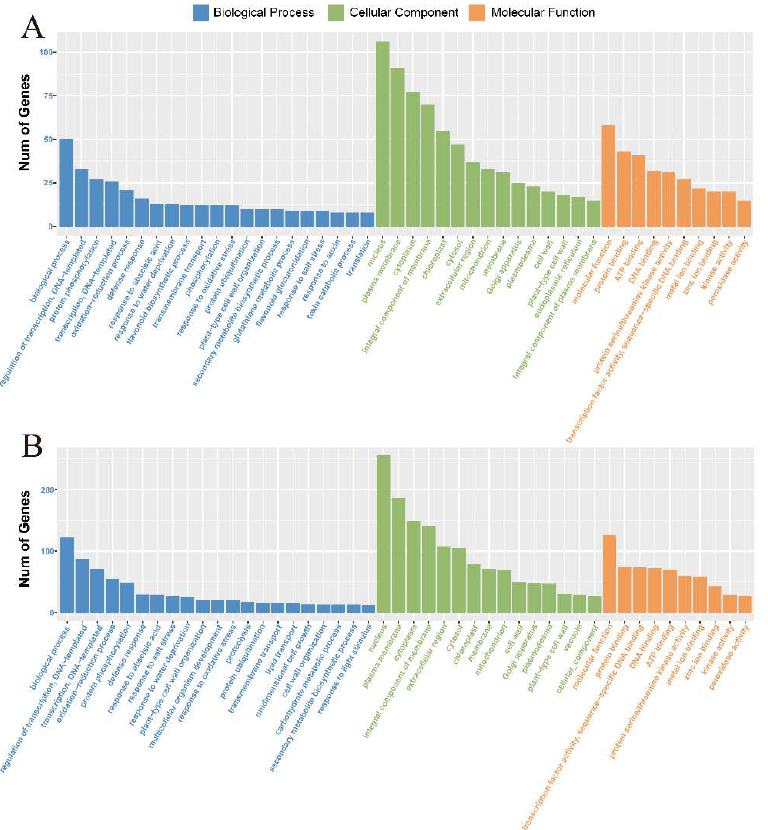
Figure 3 . Functional annotation of assembled sequences based on gene ontology categorization in M-81E ( A ) and Roma ( B ). Results are summarized under three main functional classes: biological processes, molecular functions, and cellular components.